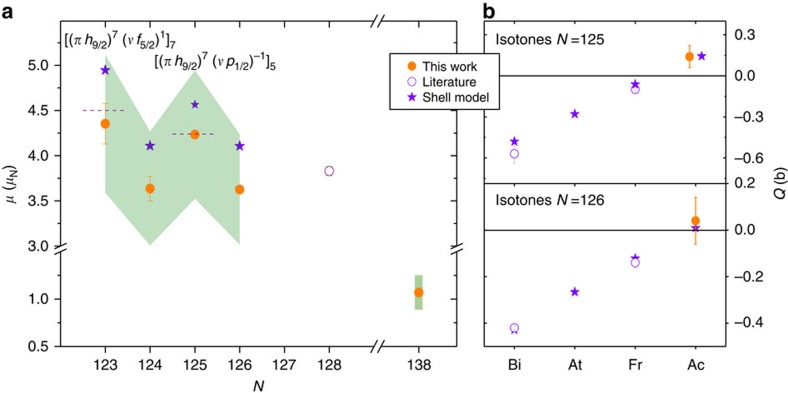
Magnetic dipole and electric quadrupole moments.(a) Experimental magnetic moments of the Ac isotopes (filled dots) compared with values obtained from large-scale shell-model calculations (stars) and from the literature (open dot). Error bars accounting for statistical (2σ) and systematic (1σ) s.d. are assigned to our data points, while the shaded band represents the 17% systematic uncertainty from the atomic-physics calculations. The values obtained after applying the additivity rule (dashed lines) using the indicated spin and nucleon configuration are also shown for the odd–odd isotopes. (b) The quadrupole moments for the N=125 (top) and N=126 (bottom) isotones including the actinium isotopes (filled dots) and the neighbouring odd-Z isotopes of francium, astatine and bismuth taken from the literature (open dots) are shown along with the values from shell-model calculations (stars). The literature values are taken from ref. 24 with the exception of those for 208,209Bi (ref. 49).